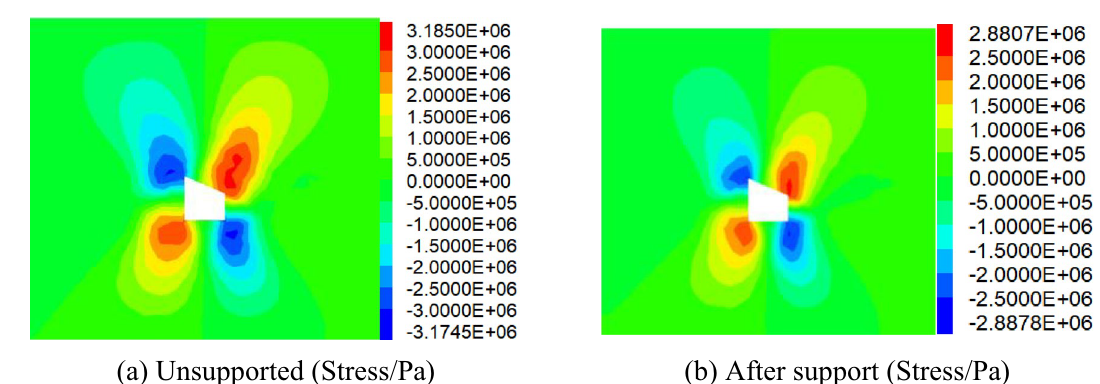
Figure 24. Vertical stress nephogram of the roadway.